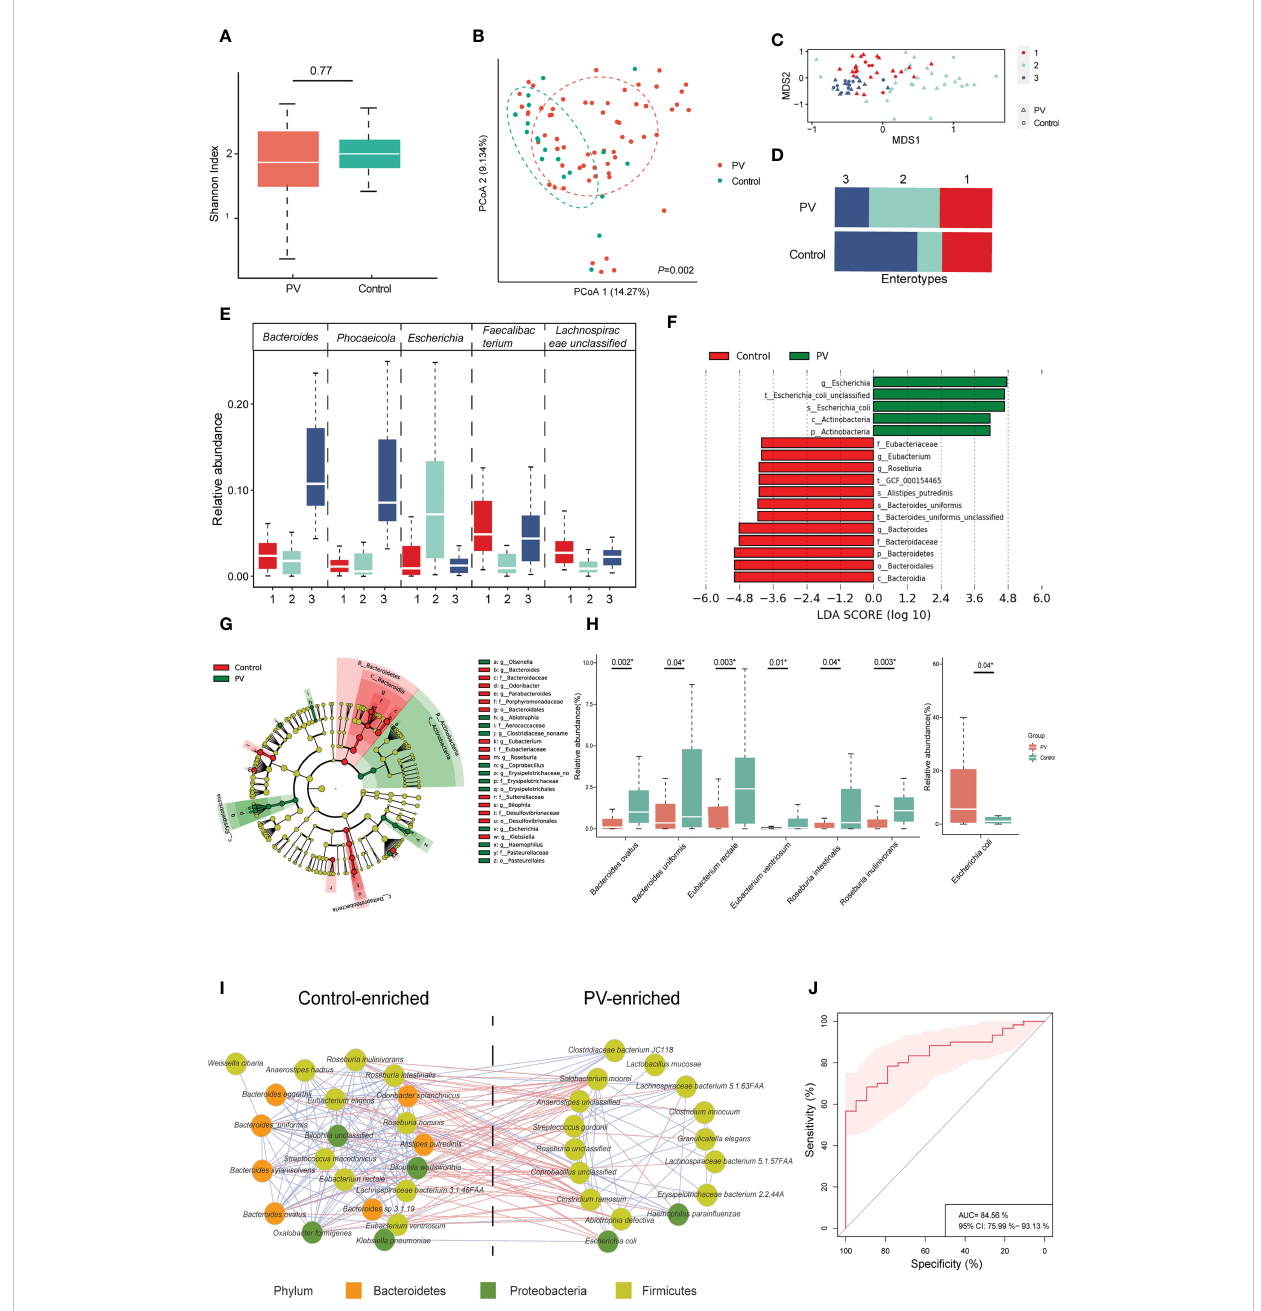
FIGURE 1 Diversities, enterotypes and differential microbial species between PV and healthy controls. (A, B) The a -diversity and b -diversity of the gut microbiome in the PV and healthy control groups; (C) The distribution of the three enterotypes is shown in descending order using non-metric multidimensional scaling; Red, green and blue represent enterotype1, enterotype2, and enterotype3 respectively, while the triangle represents patients with PV and the circle represents healthy controls; (D) Proportion of enterotypes distribution in PV and healthy controls; (E) The dominant genus of each enterotype; (F, G) Results of differential bacteria between PV and healthy controls by LEFse analysis; (H) Main differential species between the healthy control and PV groups (* represents statistical signi fi cance with the P value <0.05 using Wilcoxon sum-rank test); (I) The interaction of differential species between patients with PV and healthy controls, with the red line representing negative correlations and the blue line representing positive correlations; only species with absolute values of correlation coef fi cients greater than 0.25 are shown; (J) Species-based identi fi cation of pemphigus vulgaris; ROC curve for the set with an AUC of 84.56% and the 95% CI of 75.99% to 93.13%. PV, pemphigus vulgaris; PCoA, principal coordinates analysis; LEFse, LDA effect size analysis; LDA, linear discriminant analysis; ROC, receiver operating characteristic curve; AUC, the area under the receiver operating curve; CI, con fi dence